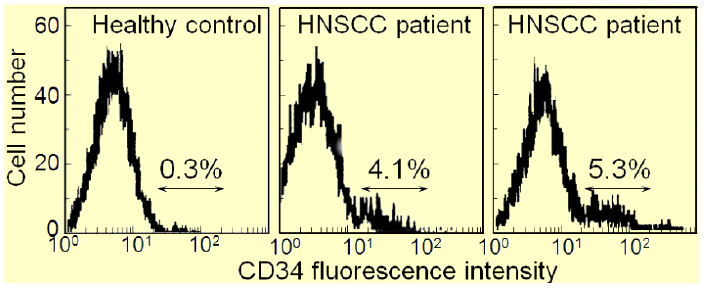
Figure 1. Increased levels of CD34 + cells in peripheral blood of HNSCC patients.